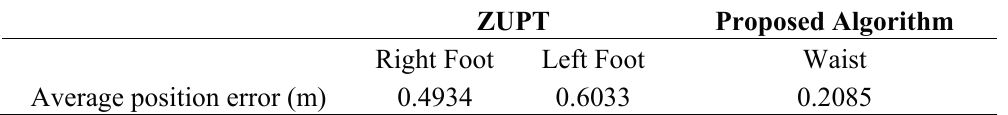
Table 1. Average position error of proposed algorithm and ZUPT with respect to Vicon data.